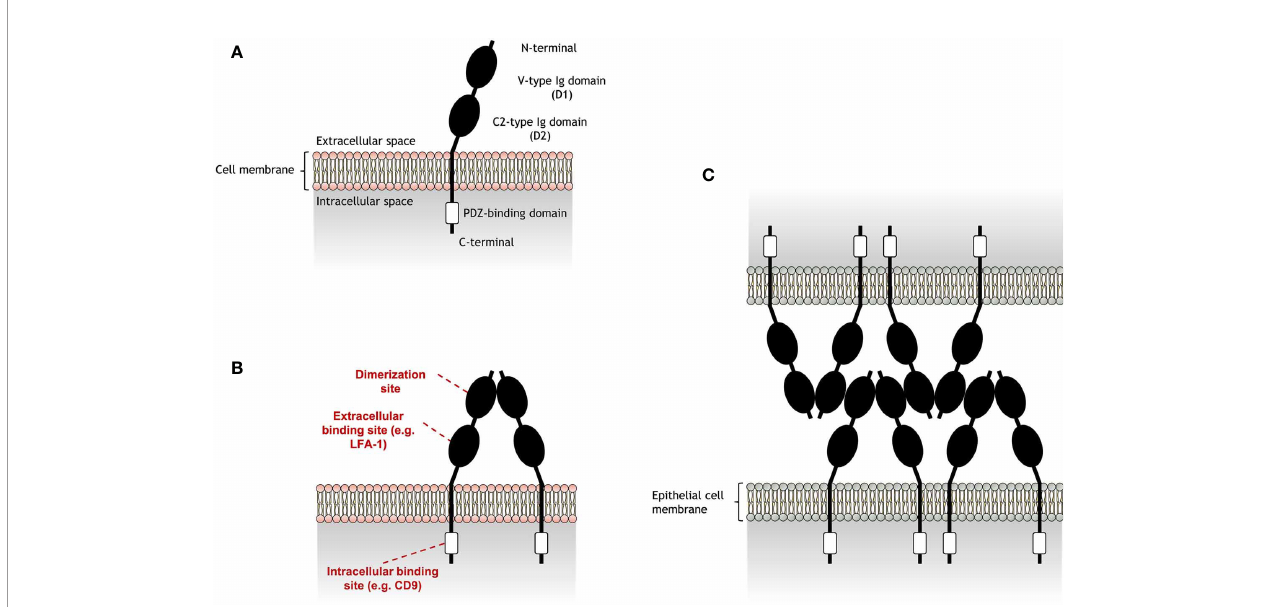
FIGURE 1 | Schematic representation of junctional adhesion molecule-A (JAM-A) structure and homophilic adhesion. (A) JAM-A is composed by an extracellular region and a cytoplasmatic tail, connected by a transmembrane portion. JAM-A extracellular portion is formed by a membrane-distal V-type Ig-like domain (D1), which also includes a N-terminal portion, and a membrane-proximal C2-type Ig domain (D2). These Ig-like domains are linked by a short connector region. JAM-A cytoplasmatic tail contains a PDZ-binding motif that is linked to a C-terminal portion. JAM-A can be expressed on the cell surface as monomers, but can also interact with JAM-A monomers in cis interactions to form (B) homodimers in a process called dimerization. While the D1 domain is the region in which JAM-A monomers interact with each other, the D2 region can bind to other extracellular ligands in trans interactions [e.g. lymphocyte function-associated antigen 1 (LFA-1)]. In addition, the PDZ-binding domain allows JAM-A to bind to scaffold proteins, such as CD9, responsible to link JAM-A to b 3 integrin. (C) Endothelial JAM-A homophilic adhesion consists of dimers on opposing cells forming contacts via the D1 domain and allows strong cell-cell adhesion in tight junctions for the formation of a molecular barrier that ensures the homeostasis of epithelial barrier integrity. JAM-A trans cell-cell arrangement was reported by Kostrewa et al.